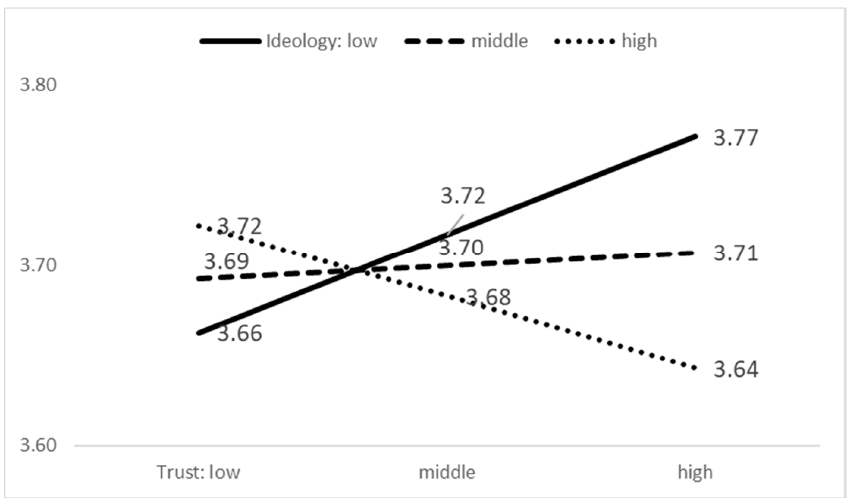
Figure 6. Perceived benefit (IV) × individualism (M) = skepticism (DV).